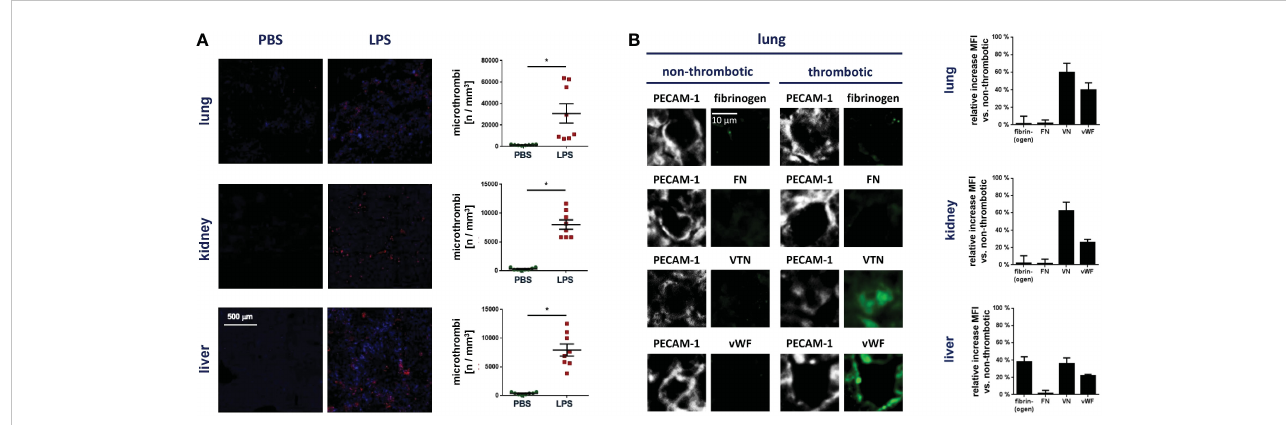
FIGURE 1 VN accumulates in the thrombotic microvasculature during systemic in fl ammation. (A) Accumulation of Gr-1 + immune cells (red) and GPIb b + platelets (blue) during thrombus formation in microvessels as analyzed by immunostaining and confocal microscopy in tissue sections of lungs, kidneys, and livers from WT mice treated with PBS or LPS, representative images and quantitative data for the occurrence of microthrombi are shown (mean ± SEM for n=7-20 per group; #p<0.05 vs. PBS). (B) The relative increase in the deposition of fi brin(ogen), FN, VN, or vWF in microvascular thrombi as compared to non-thrombotic microvessels of diseased animals was assessed by immunostaining and confocal microscopy, representative images are shown for lungs (PECAM-1/CD31 in gray; fi brin(ogen), FN, VN, or vWF in green) and quantitative data are shown for lungs, kidneys, and liver (mean ± SEM for n=4 per